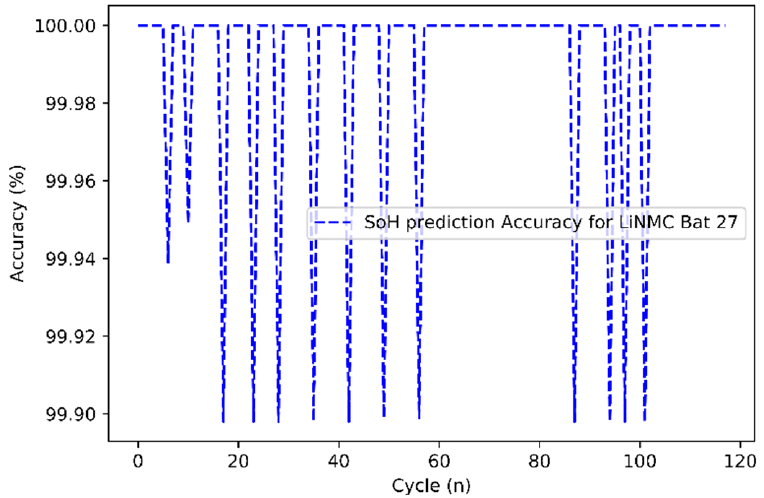
Figure 14. The accuracy in prediction of SOH for battery 27. Secondly, the ML algorithmic module’s default accuracy, R-Squared (R2) and Mean Square Error (MSE) were used as another accuracy metric. The R2 metric measures the goodness of a fit. The value ranges from 0 to 1; 1 indicates a better model fit. MSE is the mean of the squared errors. The MSE indicates how close the predicted values are to the actual values; hence, a lower MSE value signifies good model performance. The accuracy score of the training set of the battery model was 0.9999, and the testing set was